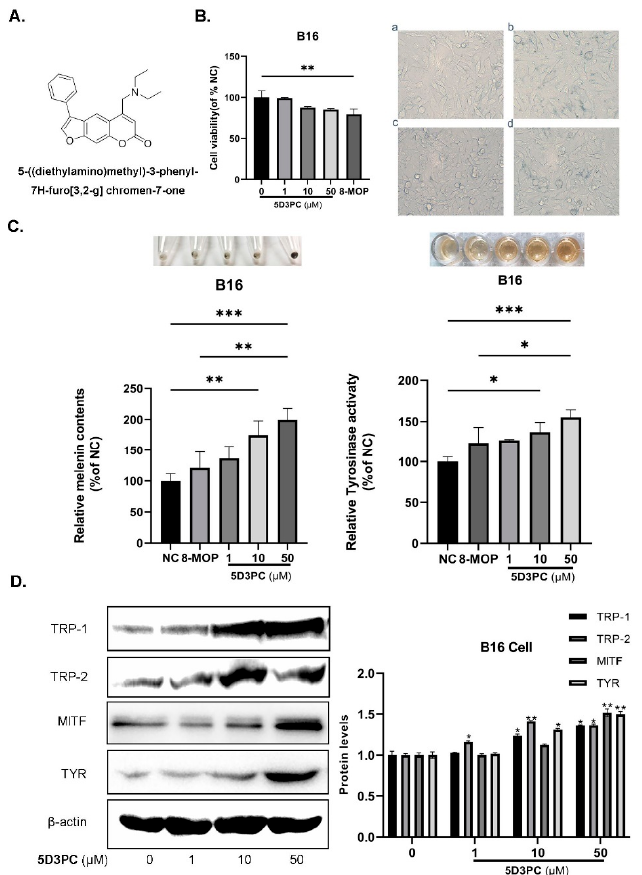
Figure 1. 5D3PC promoted melanogenesis in B16 cells ( A ) Chemical structure of the 5D3PC; ( B ) Different concentrations (0–50 μ M) of 5D3PC on B16 cell viability were measured by CCK-8 assay. Morphological changes in 5D3PC treated B16 cells at 200 × magnification. ( a ) 0.1%DMSO ( b ) 1 µ M 5D3PC, ( c ) 10 µ M 5D3PC, and ( d ) 50 µ M 5D3PC. ( C ) Effect of 5D3PC on melanin content and TYR activity in B16 cells. Melanin content of B16 cells treated with different concentrations (1, 10, and 50 µ M) of 5D3PC for 48 h. TYR activity in the similarly treated B16 melanoma cells. DMSO (0.1%) was used as the vehicle control, and 8-MOP (50 µ M) as the positive control. ( D ) Western blotting assays determined the levels of melanogenic genes in B16 cells treated with different concentrations (0–50 µ M) of 5D3PC. All results are expressed as mean ± SD; statistical analysis was performed with one-way ANOVA, followed by Tukey’s multiple comparisons test. * p < 0.05, ** p < 0.01, and *** p < 0.001 compared with NC (negative control)